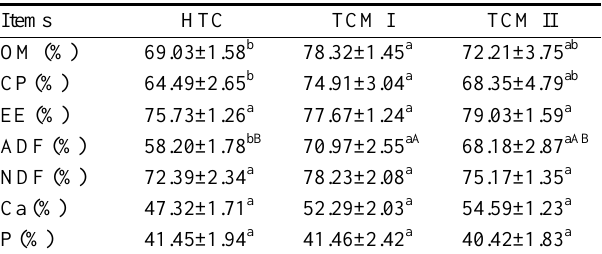
Table 6. Effects of two TCM treatments on nutrient apparent